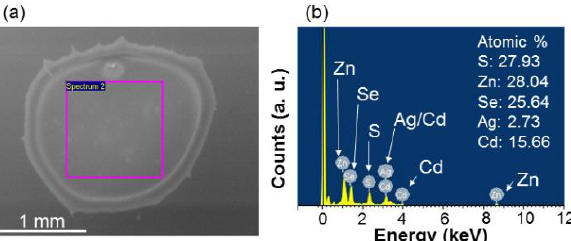
Figure 8. ( a ) SEM image of the dried drop-casted droplet on a GaN template with the same Ag NP and QD compositions as those of sample NP-GQD&RQD. The EDX scanning region is circled by the pink square. ( b ) EDX scanning intensities of various compositing elements of the Ag NPs and QDs. The atomic percentages of those recorded elements are shown in part ( b